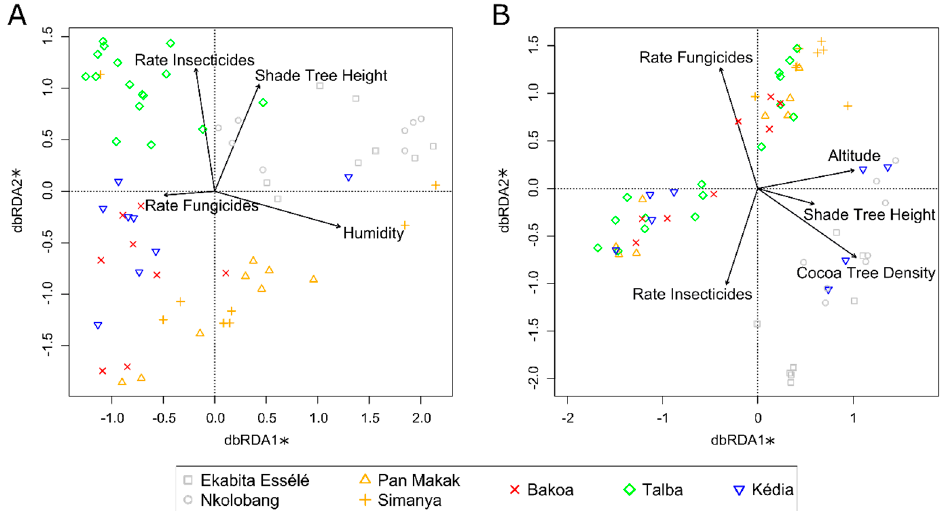
Figure 4. Distance-based redundancy analysis (db-RDA) plot showing the relationship of environmental properties and agroforestry management system to foliar fungal ( A ) and bacterial ( B ) endophyte communities of T. cacao . Ordination is based on weighted Bray-Curtis distances between samples and is color-coded by sampling region. Factors were chosen that significantly ( p ≤ 0.05) contributed to the model. Axes labelled with an asterisk are significant. The first axes explained 42.5% (bacteria) or 42.2% (fungi), whereas the second axes explained 28.1% (bacteria) or 22.6% Table 2. Results of the db-RDA that describes the effect of environmental properties and agroforestry management systems on endophyte community composition in T. cacao leaves.